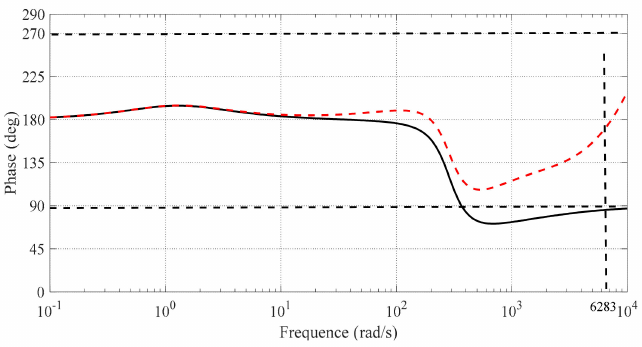
Figure 11. Phase–frequency curve of F ( s ) (black line) and C ( s ) F ( s ) (red dotted